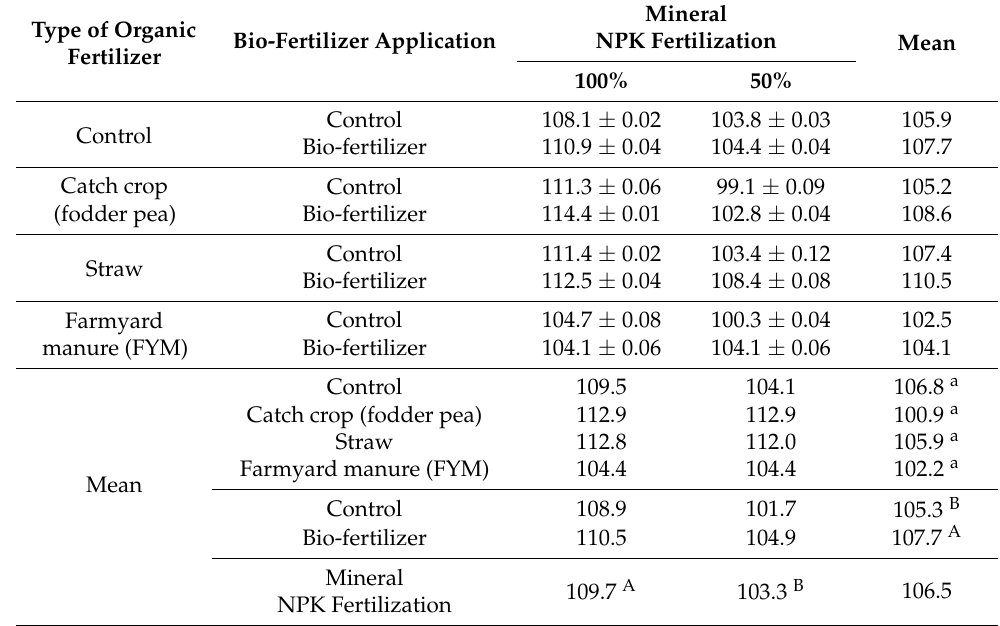
Table 2. Total protein content in potato tubers after harvest depending on the applied research factors (g · kg − 1 of dry weight) (mean from 3 years).